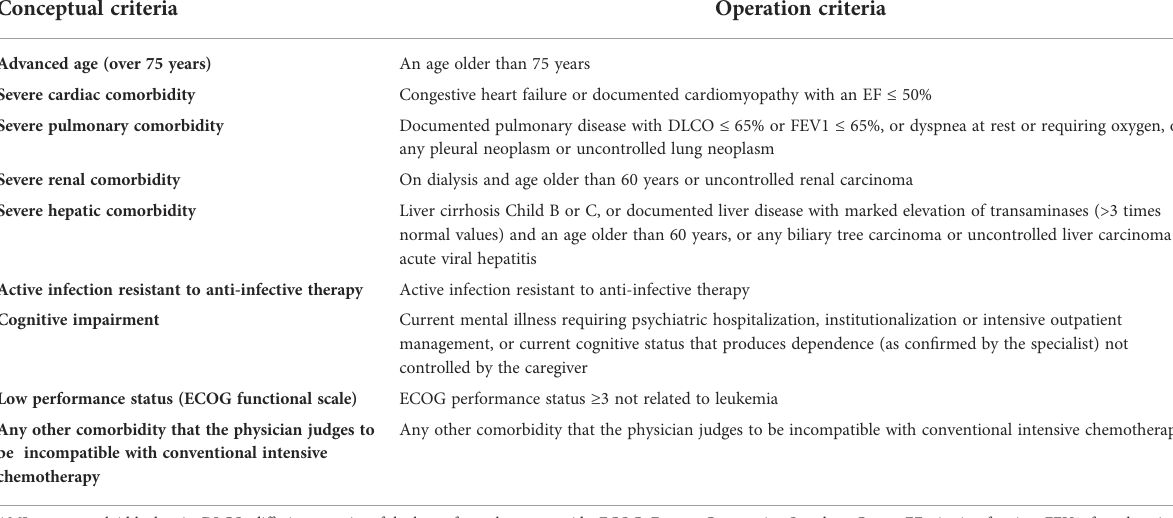
TABLE 1 Conceptual and operation criteria to de fi ne AML patients ’ un fi tness to intensive chemotherapy. Conceptual